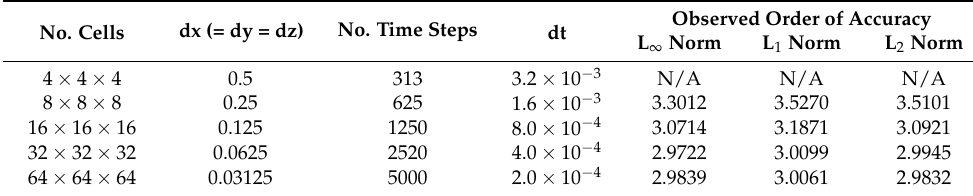
Table 4. Observed order of accuracy of the 2D third-order solver.